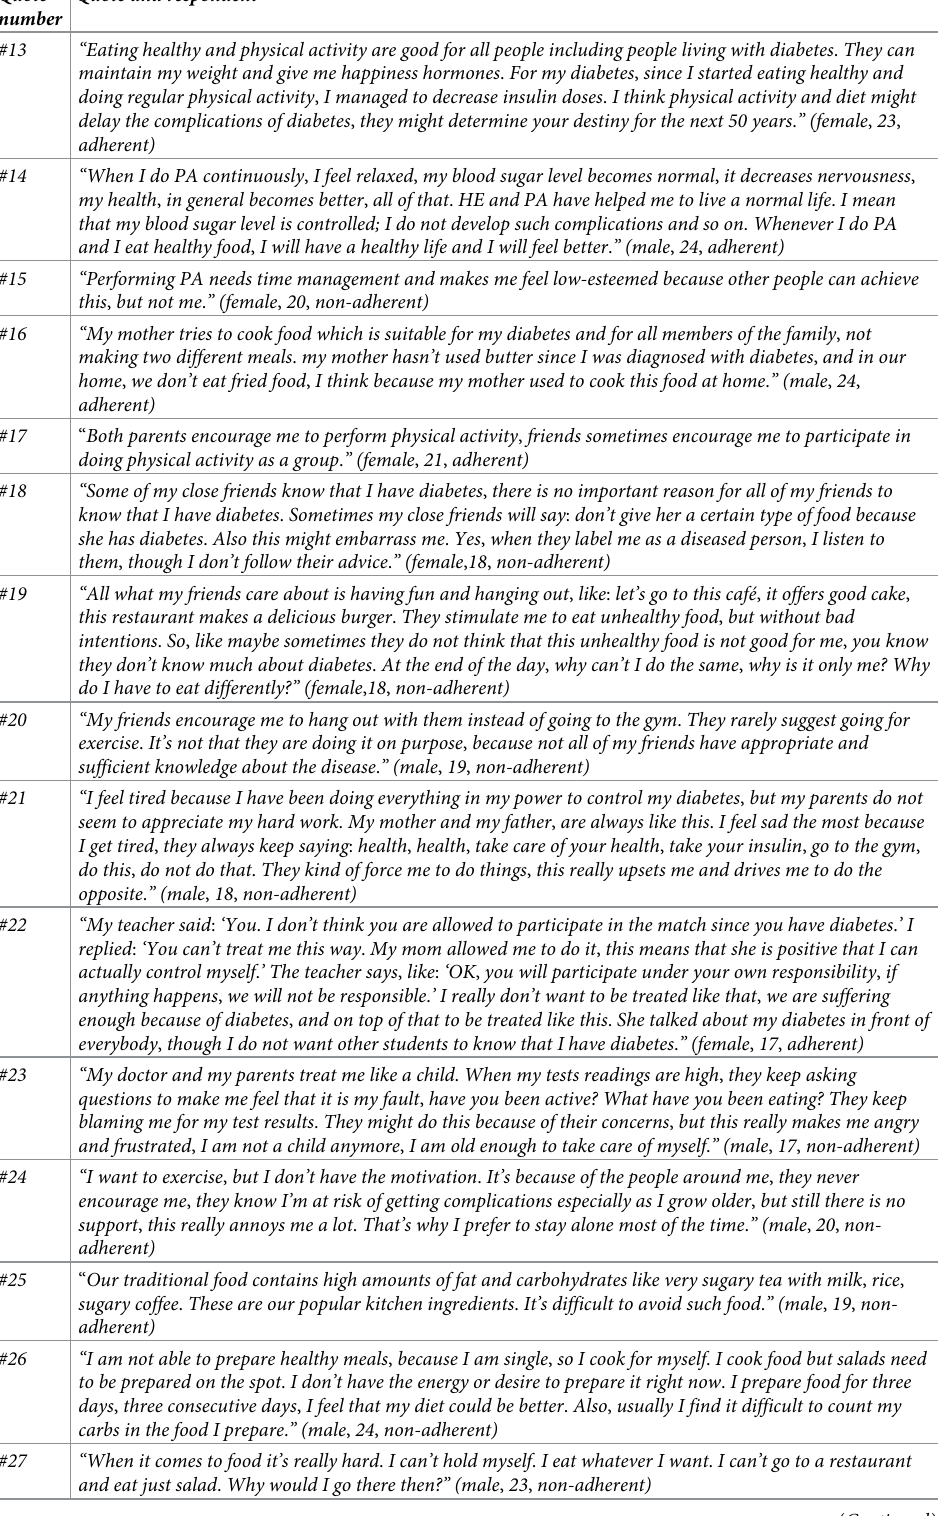
Table 4. Interviewee quotes: Motivational